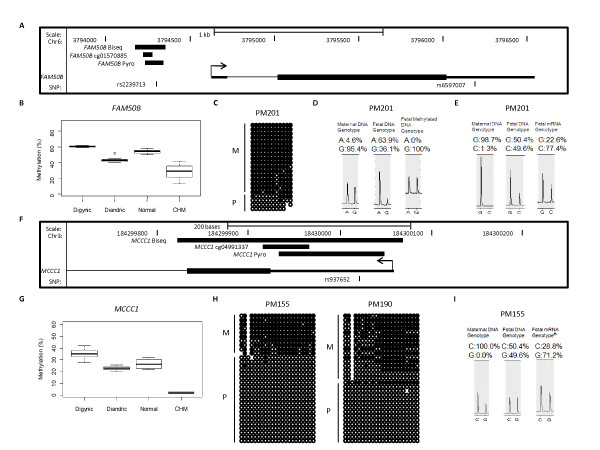
Identification of imprinted DMRs at the proximal promoter regions of FAM50B and MCCC1. (A) and (F) Schematics showing the positions of methylation assays (Biseq: bisulphite cloning and sequencing assay; cg code: probe number of Illumina assay; and Pyro: bisulphite pyrosequencing assay) and SNP locations relative to the genes. Arrow directions represent the transcriptional directions for the genes. Genomic coordinates were retrieved from the UCSC Genome Brower database (hg18). (B) and (G) Box plots showing the methylation levels of samples from each placental group for the DMRs analyzed by bisulphite pyrosequencing. Both DMRs in FAM50B and MCCC1 have higher methylation in digynic than diandric triploid placentas, while they have intermediate methylation in normal placentas and particularly low methylation in CHMs. (C) and (H) Bisulphite cloning and sequencing showing parental origins of methylated and unmethylated alleles (M: maternal alleles; P: paternal alleles). Parental origin was determined by genotyping heterozygous informative SNPs for each sample. The DMRs in both FAM50B and MCCC1 are maternally methylated. Each black circle represents a methylated CpG dinucleotide, and each white circle represents an unmethylated CpG dinucleotide. (D) Quantitative genotyping of methylated alleles by pyrosequencing. SNP rs2239713 is homozygous (GG) in maternal DNA and heterozygous (AG) in foetal (placental) DNA (dispensation order: AAG). Genotyping of the placental sample using a methylation-specific pyrosequencing primer shows a homozygous (GG) pattern, indicating that the DMR associated with the maternally inherited 'G' allele is methylated while the one associated with the paternal 'A' allele is not. (E) and (I) Quantitative genotyping of expressed alleles by pyrosequencing. Both SNPs (E) rs6597007 (dispensation order: GGC) and (I) rs937652 (dispensation order for DNA genotyping: CG; dispensation order for RNA genotyping: CCG) are homozygous in maternal DNA and heterozygous in foetal DNA. Genotyping of cDNA shows a bias towards preferential expression of the paternal alleles. *The pyrosequencing primers used for cDNA genotyping (intron-spanning) in MCCC1 were different from those used for DNA genotyping (Table S10 in Additional file 2), so the peak ratio shown in genotyping the pyrogram of cDNA does not correspond to that for DNA.